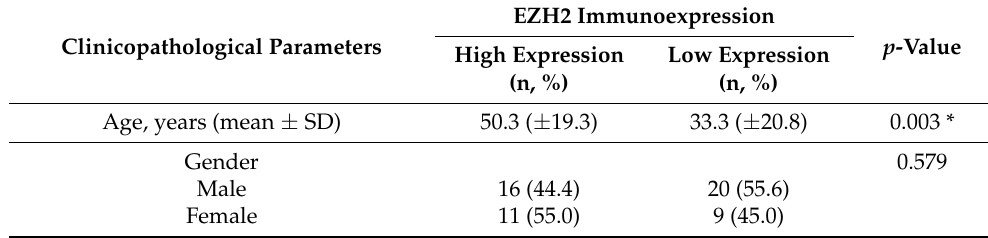
Table 2. EZH2 immunoexpression in gliomas and its association with clinicopathological parameters.